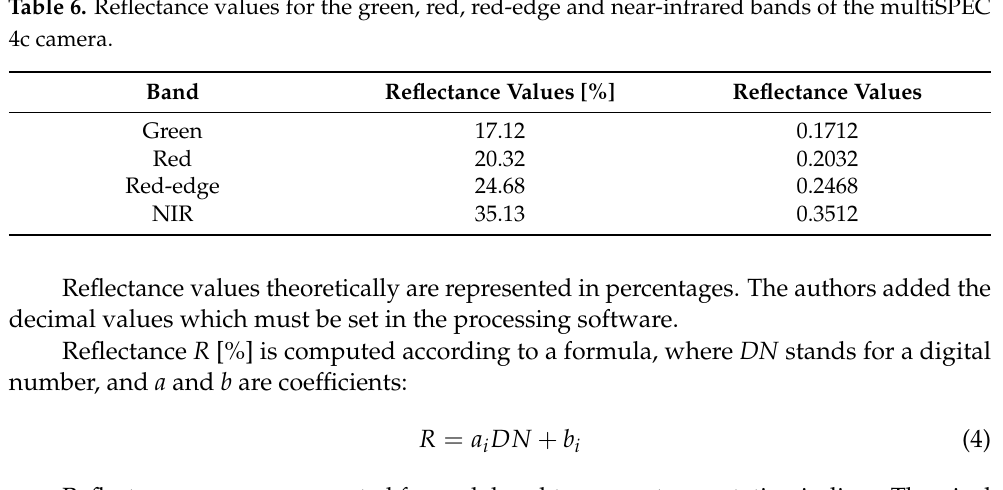
Table 5. Reflectance values for the green, red, red-edge, and near-infrared bands of the Sequoia camera. Band Reflectance Values [%] Reflectance Values Green 17.1 0.171 Red 21.3 0.213 Red-edge 26.3 0.263 NIR 36.9 0.369